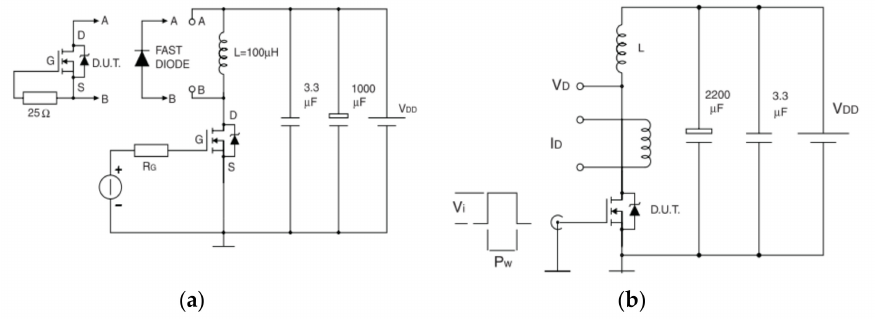
Figure 8. Test circuit for inductive load switching and diode recovery times ( a ) and unclamped Inductive load test circuit ( b